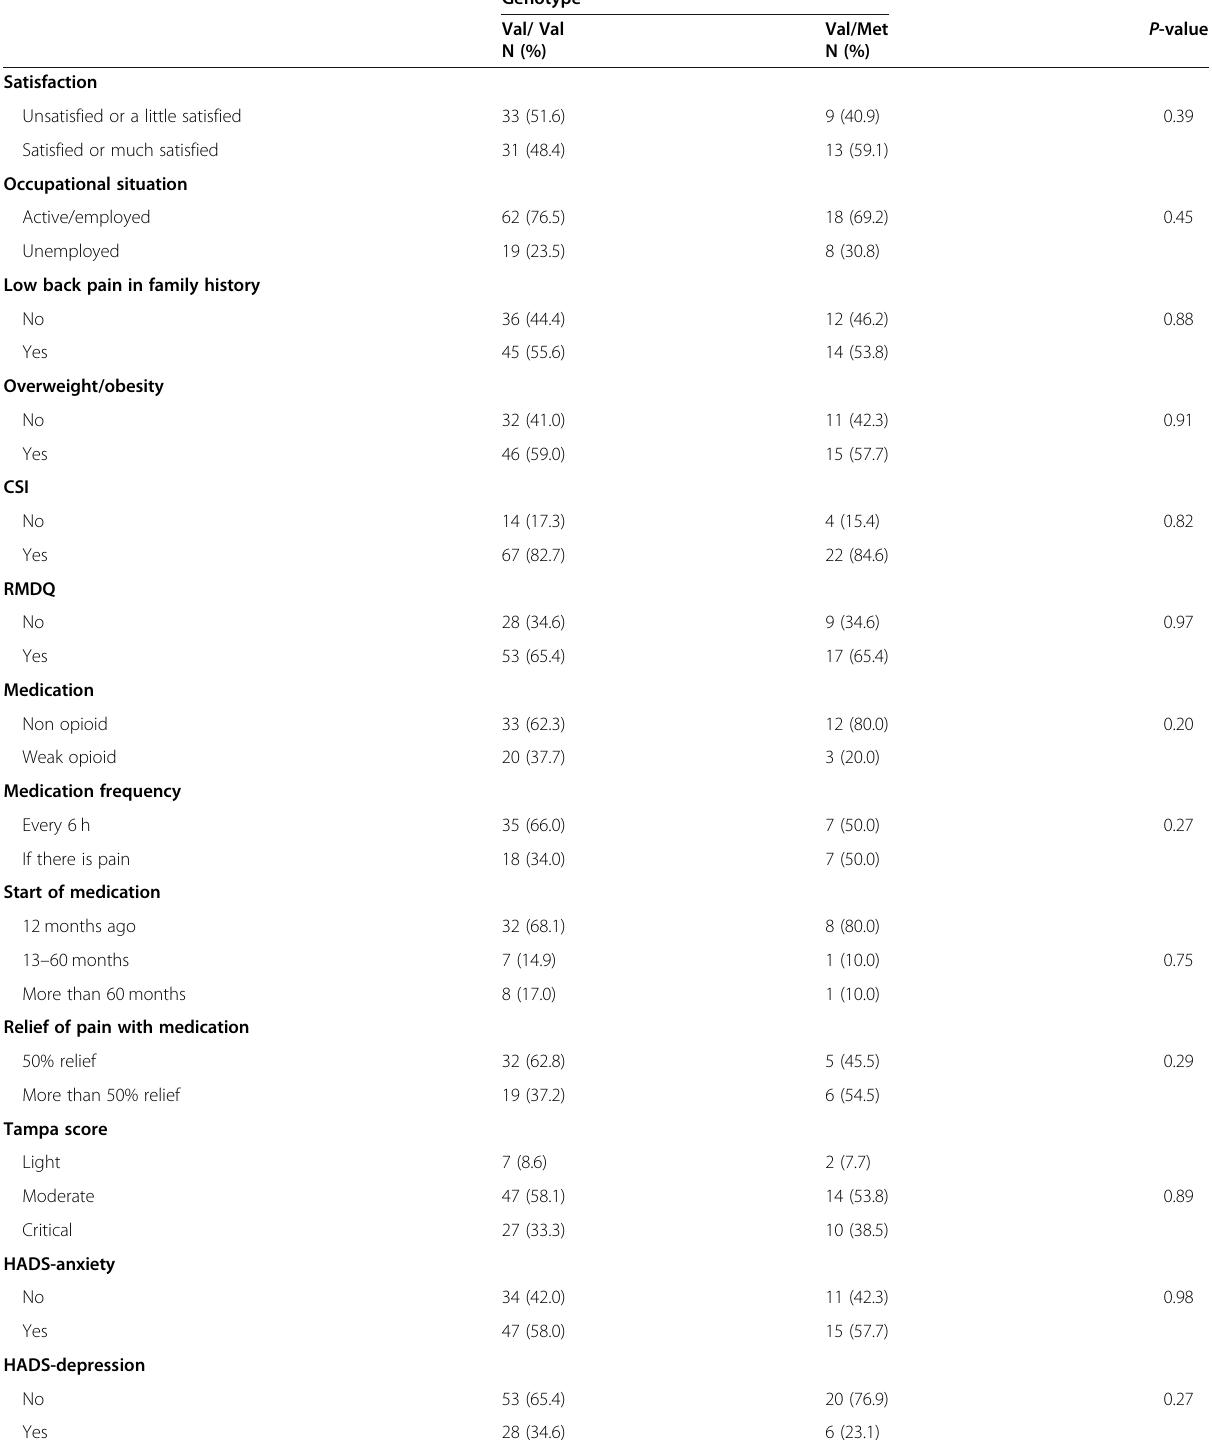
Table 3 Comparison of the qualitative variables according to the BDNF Val66Met genotypes